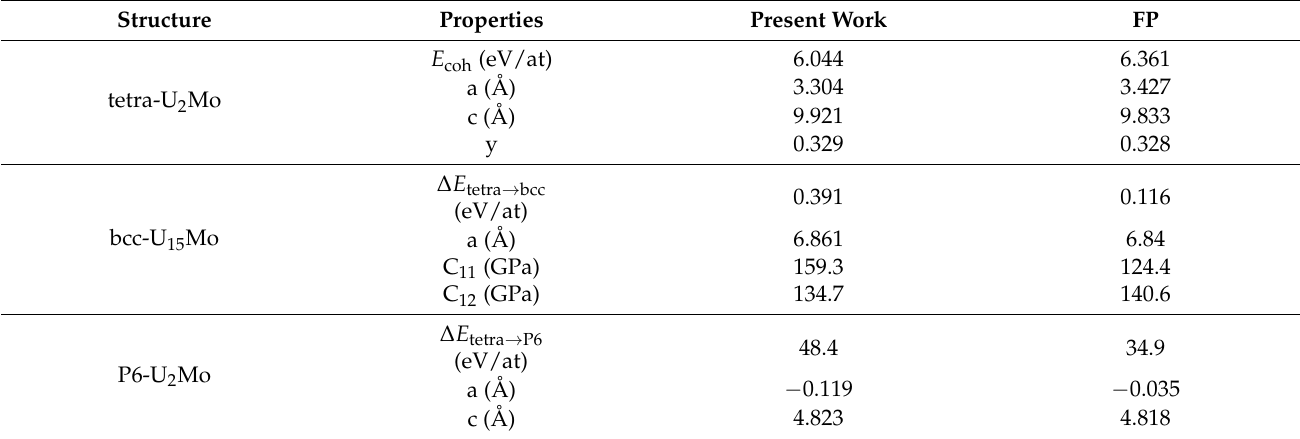
Table 4. Reproduced values of lattice constants, cohesive energies, and elastic constants of several U–Mo binary phases.